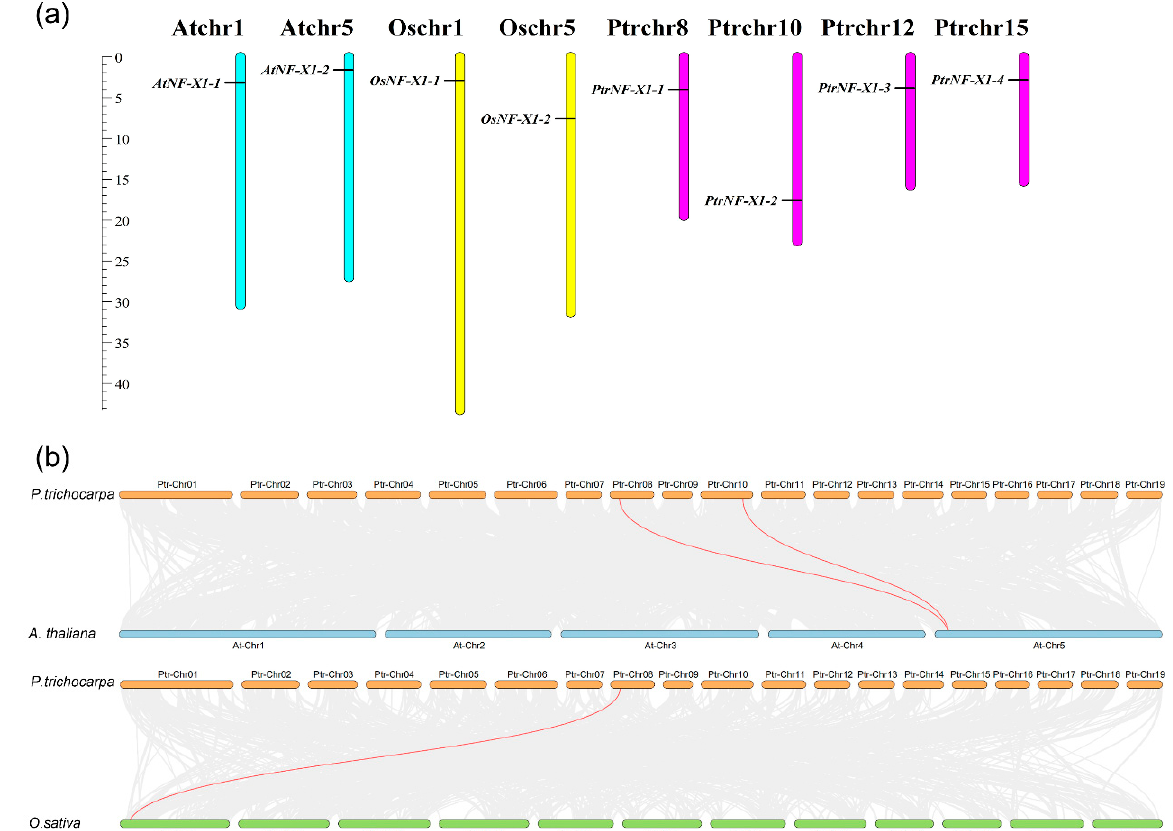
Figure 4. Synteny analysis of NF-X1 genes. ( a ) Locations of NF-X1 family genes on the chromosomes of A. thaliana, O. sativa, and P. trichocarpa . ( b ) Synteny analysis of NF-X1 genes between poplar and the other two model plants. Gray lines in the background represent the co-linear blocks in poplar and other model plant genomes, while the red lines emphasize the syntenic NF-X1 gene pairs.